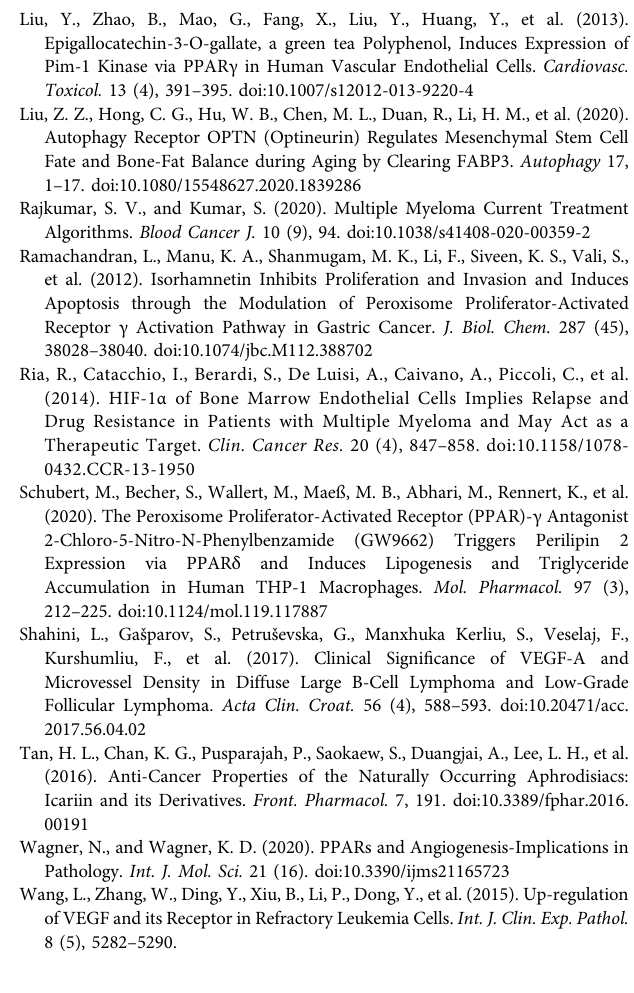
Supplementary Figure 1 | PPAR γ knockdown MM cells promote MM-induced angiogenesis. (A) Expression of PPAR γ was determined by WB in MM cell transfection with lentiviruses encoding the shPPAR γ and vector. (A,B) Tube formation experiment and HUVEC migration experiment were performed by analyzing the effects of the MM cell supernatant on the tube formation and migration of HUVECs treated with RSG or